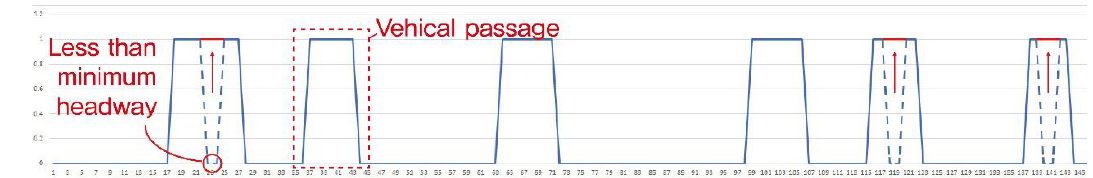
Figure 4. Final signal profile after judging the presence of vehicles based on chosen thresholds.